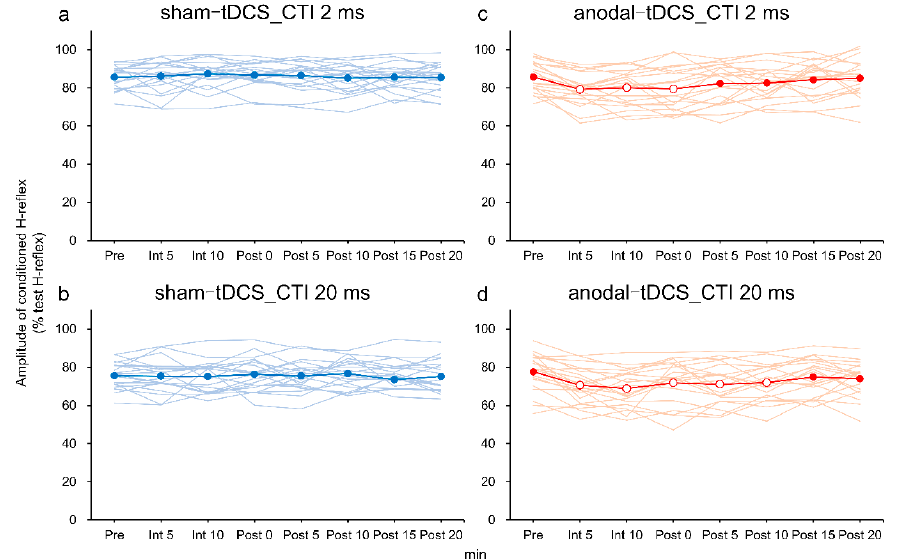
Figure 4. Comparison of the temporal changes in RI. ( a , b ) Sham-tDCS; ( c , d ) anodal-tDCS; ( a , c ) CTI of 2 ms; and ( b , d ) CTI of 20 ms. The thin solid lines show changes over time for 20 subjects, and the thick solid line indicates mean values. The vertical axis is the amplitude of the conditioning H-reflex/amplitude of the test H-reflex × 100. The horizontal axis is the measurement time of RI. Pre values were compared with those at different measurement times using a paired t -test with Bonferroni correction. Values indicated by filled symbols did not show significant differences compared with the Pre values. The open symbols indicate values significantly different from the Pre values (p < 0.05). CTI, conditioning stimulation–test stimulation interval; tDCS, transcranial direct current stimulation.